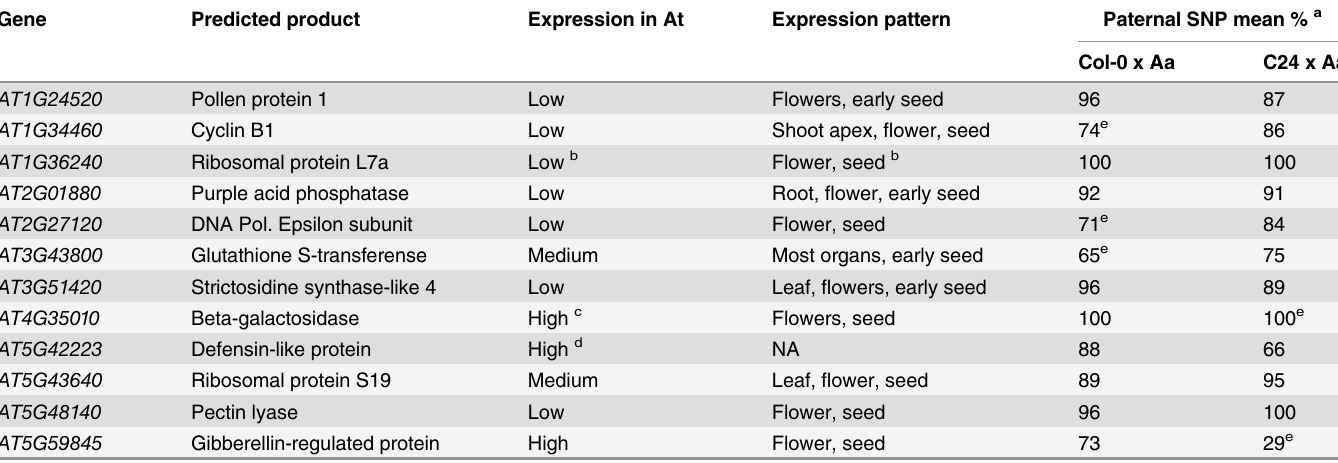
Table 4. Exemplary genes uniquely paternal in the A. thaliana x A. arenosa cross.